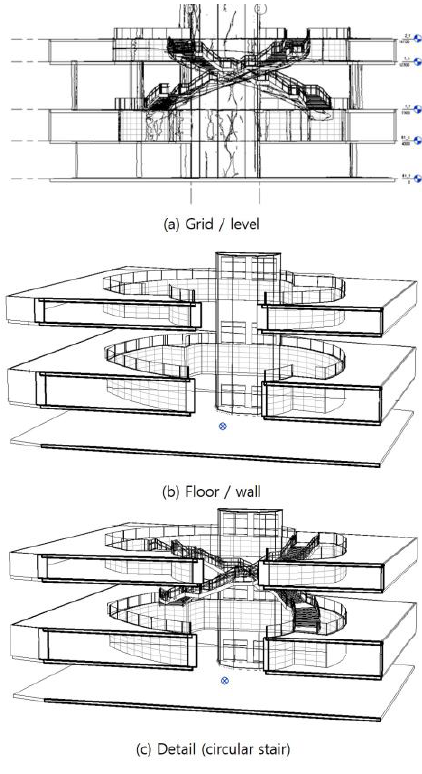
Figure 5. As-built BIM creation steps